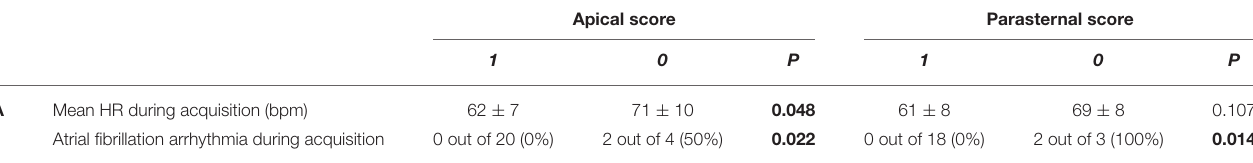
TABLE 5 | Evaluation of the impact of heart rate and heart rhythm stability on the ability of the algorithm to correctly identify the phase of the cardiac cycle. Apical